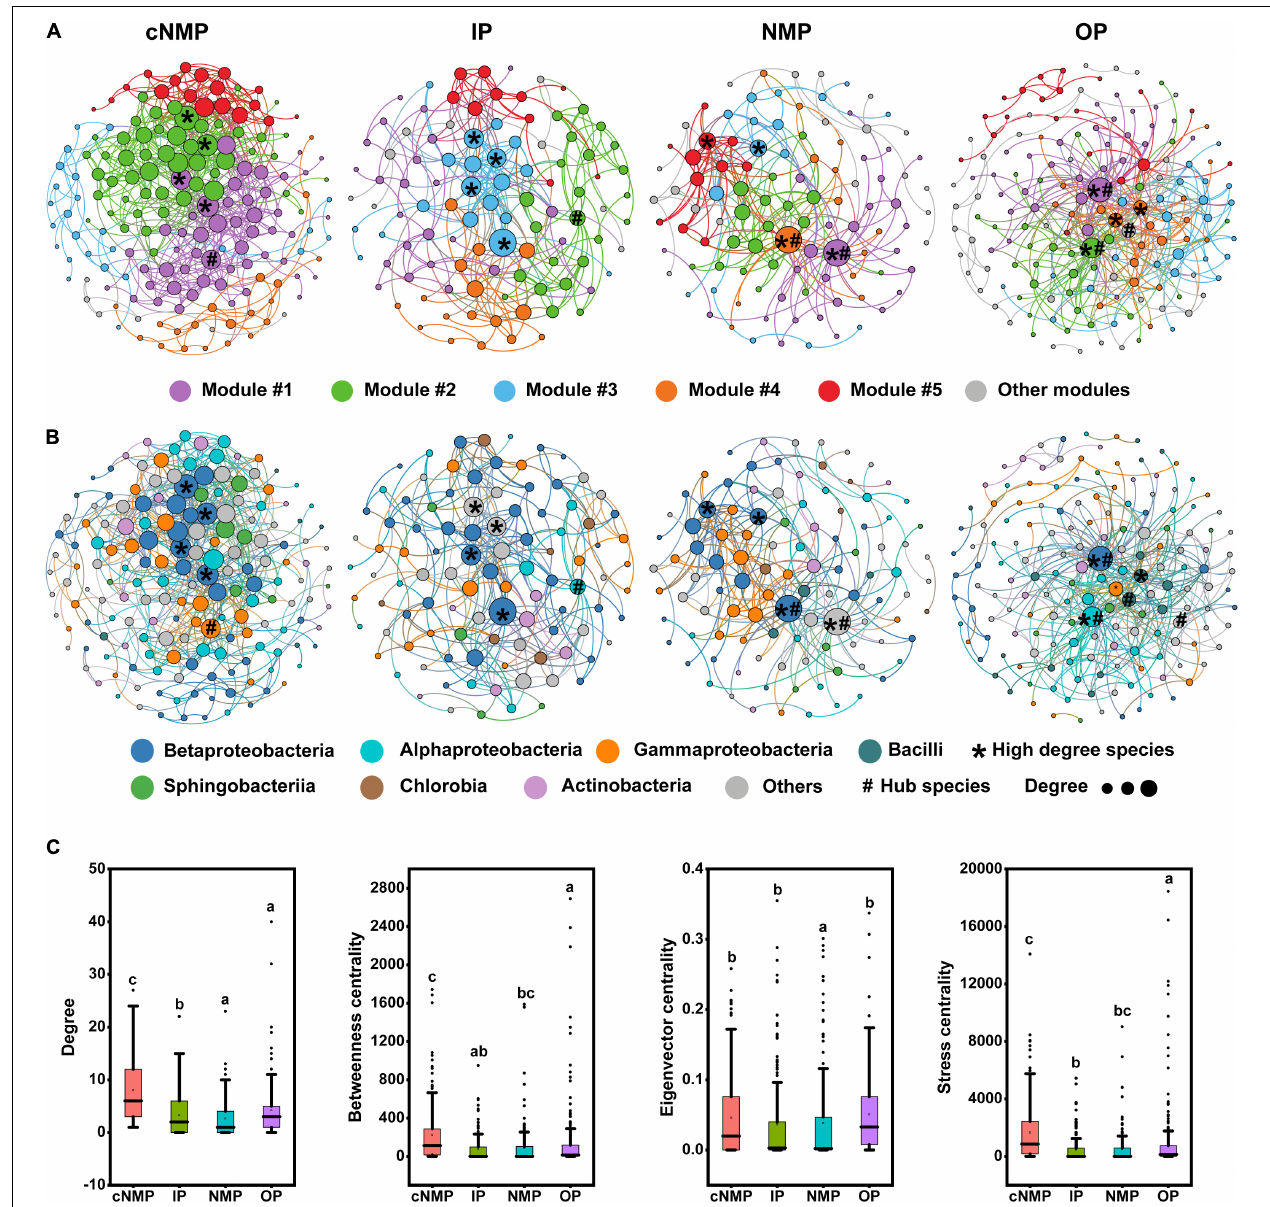
FIGURE 5 | The network was established by calculating correlations among microbial community under the influence of four kinds of phosphorus sources. The nodes of the network are colored according to (A) ecological clusters (modules) and (B) classification of bacteria at the class level. Nodes represent OTUs. The node size is proportional to the average degree, and links between nodes indicate significant correlations. Modules are randomly colored at each phosphorus source. (C) Comparison of node-level topological features among four different communities. Higher-degree species means the top four nodes with the highest links. Hub species means key species through connectivity calculation. The top and bottom boundaries of each box represent the 75th and 25th quartile values, respectively; and the line within each box represents the median values. Different letters indicate significant differences at the p < 0.05 level. OTU, operational taxonomic